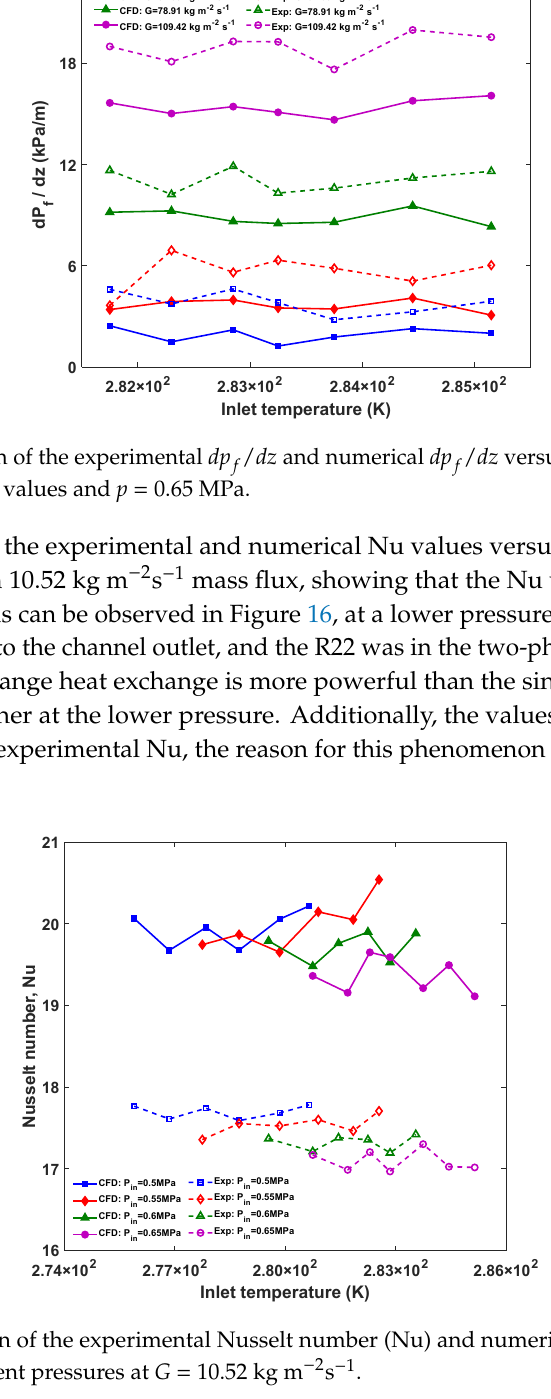
Figure 15. Comparison of the experimental Nusselt number (Nu) and numerical Nu versus the inlet temperature for different pressures at G = 10.52 kg m - 2 s - 1 .